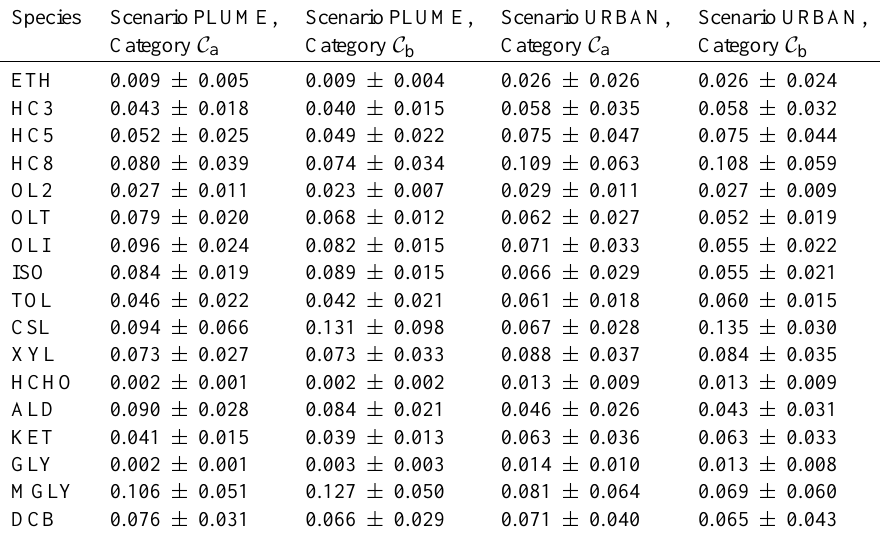
Table 7. Mean impact and standard deviation of VOCs for categories C a and C b . Considered are adjoint sensitivities with respect to initial uncertainties and final projection on